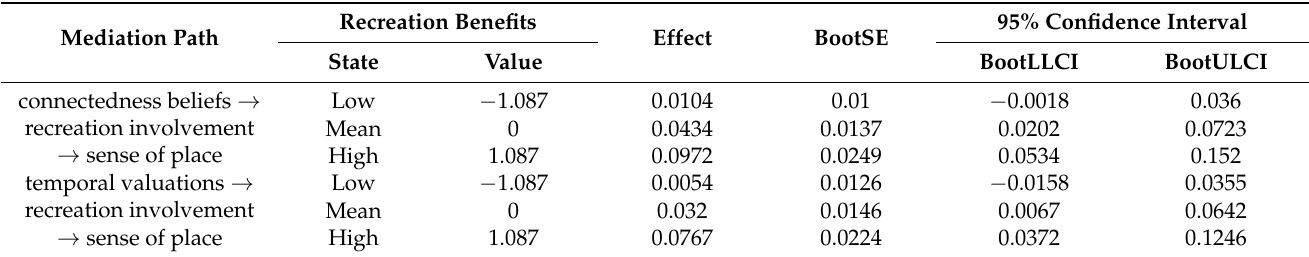
Table 6. Moderating effect of recreation benefits on mediation